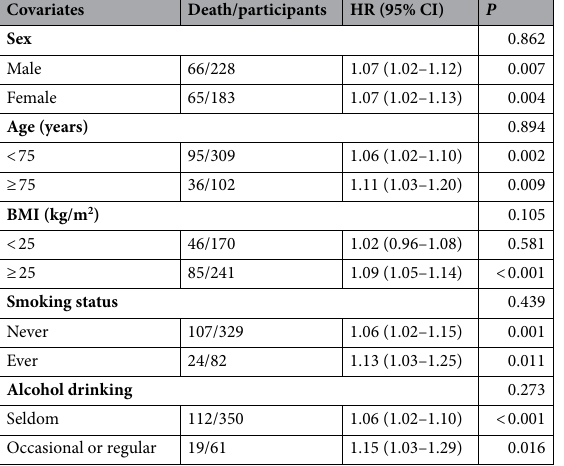
Table 4. Subgroup analyses for associations between serum selenium and the risk of mortality in patients with heart failure. Adjusted for age, sex (except in the sex-stratified analysis), body mass index, smoking (except in the smoking-stratified analysis), drinking (except in the alcohol-stratified analysis), hypertension, diabetes, chronic kidney disease, prior history of heart failure, atrial fibrillation and medication.